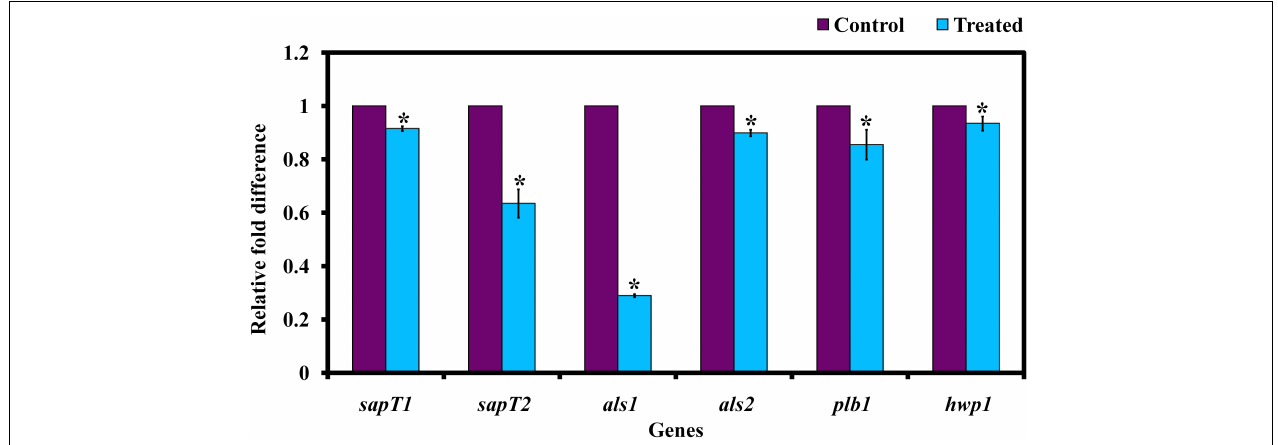
FIGURE 7 | Gene expression analysis of C. albicans in the presence and absence of morin (at MBIC). Data are presented as means ± SD. *Indicates statistical significance ( p < 0.05).